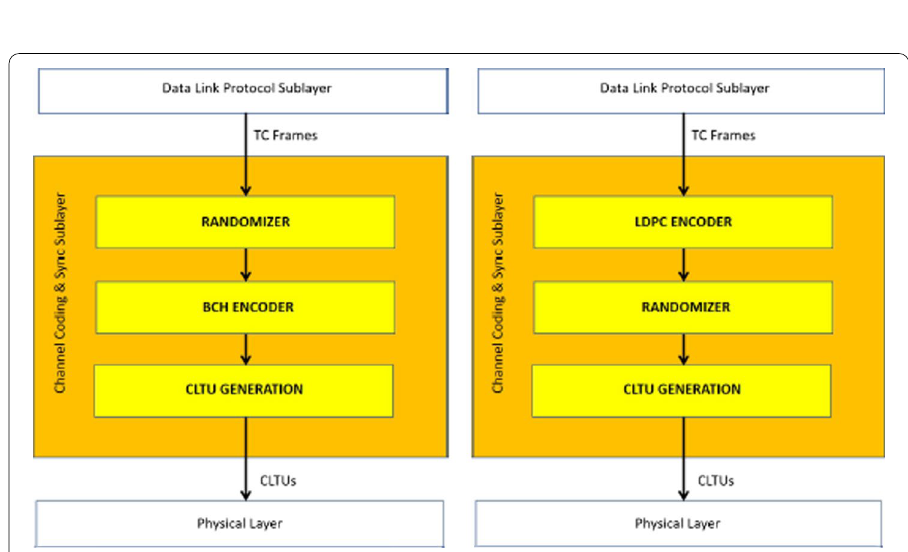
Fig. 2 Channel Coding and Synchronization sublayer: constituent blocks for BCH (on the left) and LDPC (on the right)